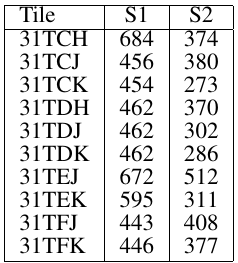
Table 1. Number of Sentinel-1 (S1) and Sentinel-2 (S2) images used over the Occitanie area